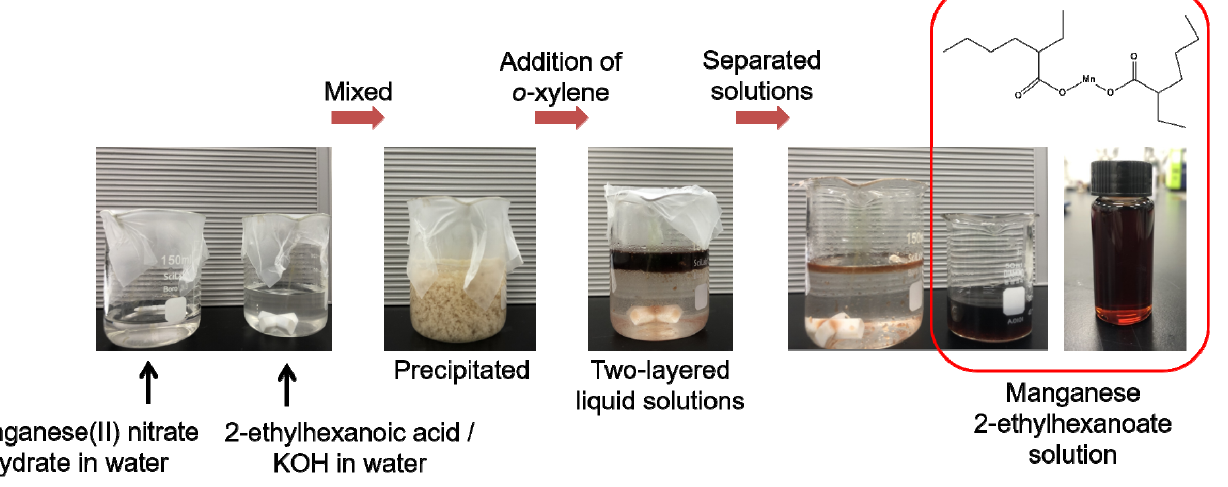
Figure 1. Schematic representation showing the preparation process of manganese 2-ethylhexanoate solution, used as MOD precursor for the fabrication of manganese oxides.